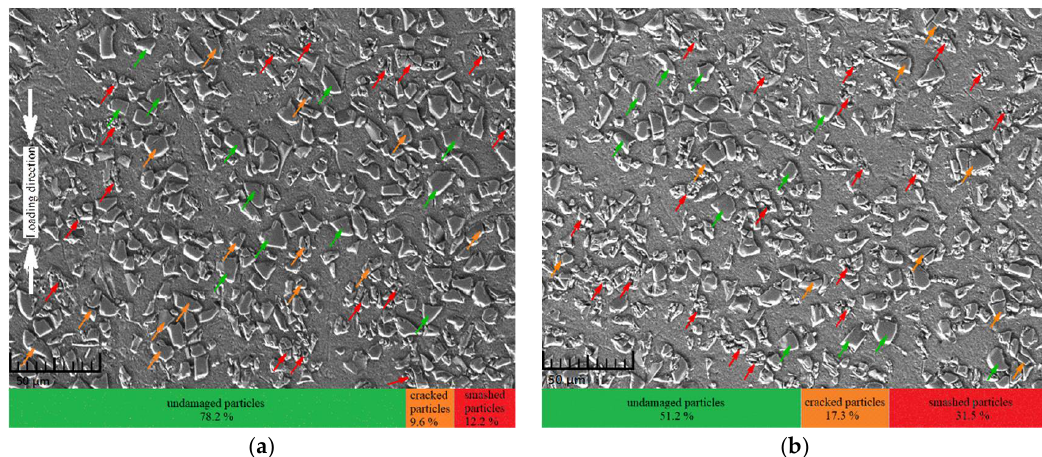
Figure 12. Micromorphology of specimens at 4500 s −1 under the RT condition. ( a ) SEM graph of the specimen under 20% deformation; ( b ) SEM graph of the specimen under 50% deformation.